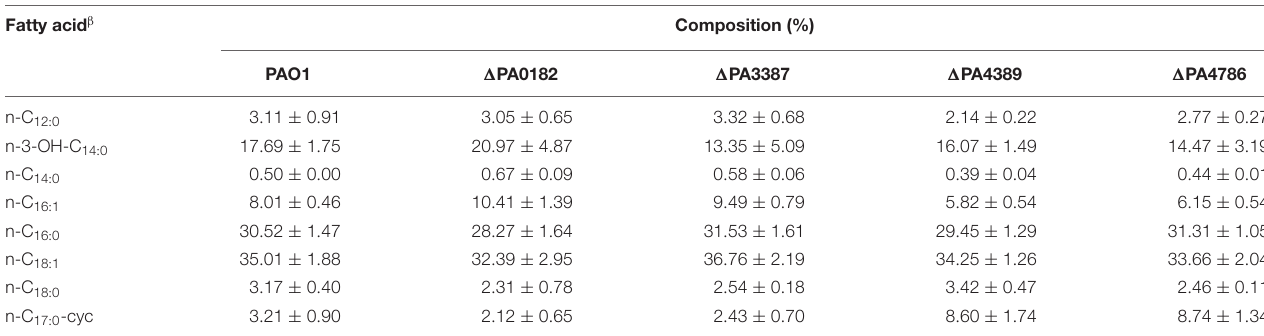
TABLE 2 | Analysis of fatty acid compositions in P. aeruginosa mutant strains α . Fatty acid